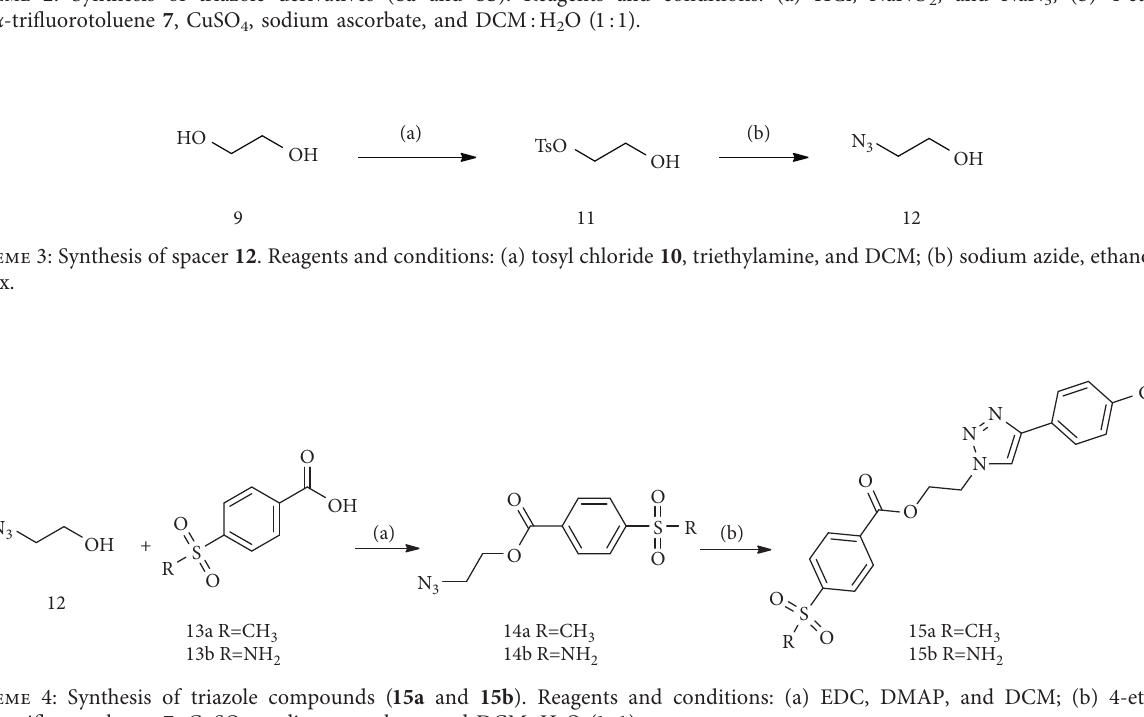
Scheme 2: Synthesis of triazole derivatives ( 8a and 8b ). Reagents and conditions: (a) HCl, NaNO